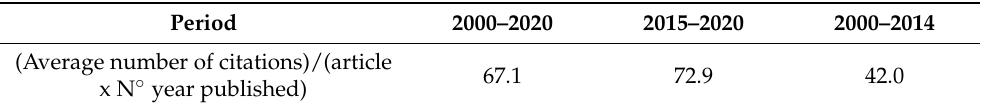
Table 1. Average number of citations per article for each period, taking into account the number of years each individual article has been published.